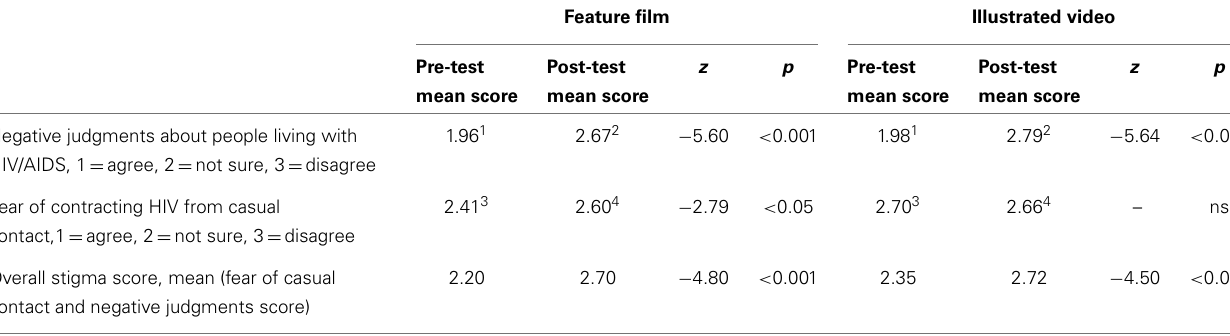
Table 3 | Pre-test and Post-testWilcoxon Signed RankTest for stigma outcome variables by treatment